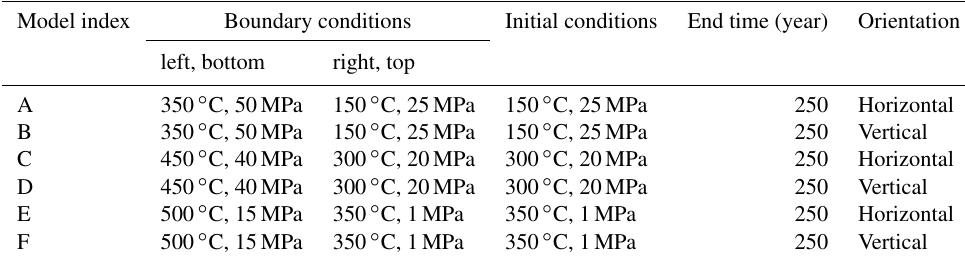
Table 3. Model parameters of 1-D benchmark